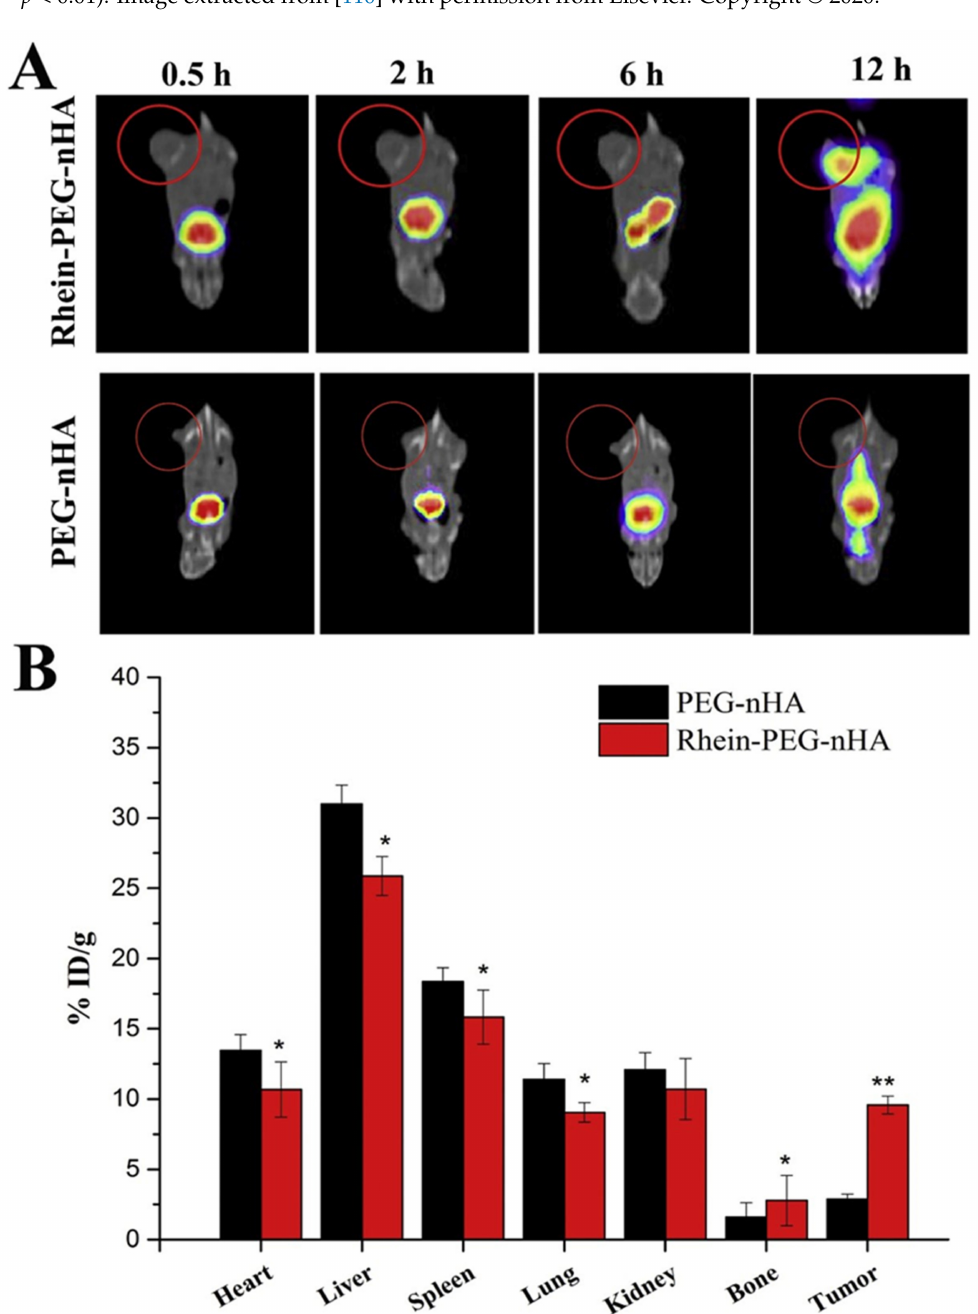
Figure 12. In vivo study of PEG-HAp and Rhein-PEG-HAp NPs for DOX delivery in bone tumor- bearing Balb/c mice model. ( A ) Analysis of the biodistribution of NPs at different time points after injection; ( B ) quantitative analysis of radioactivity uptake of the major organs at 24 h post-injection ( n = 6 ) (* p < 0.05, ** p < 0.01 vs. PEG-nHA group). Image extracted from [110] with permission